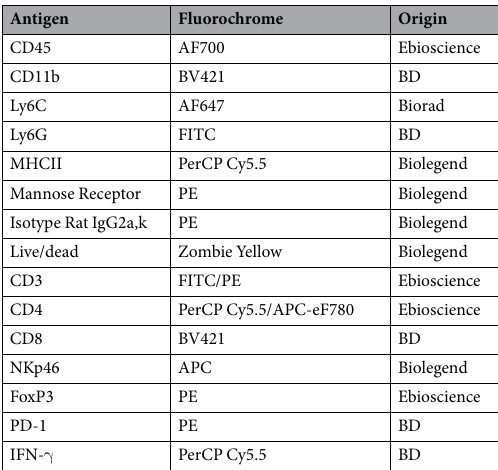
Table 1. Flow cytometry antibodies.